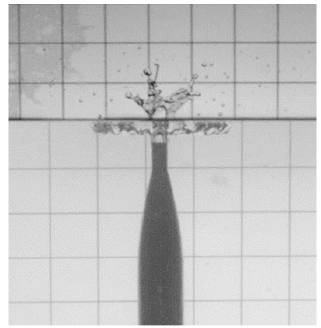
Figure 15. The splash diagram of the hydrophobic model with the initial velocity of water entry v = 2.2 m/s and the head shape hemispherical angle of 0°.